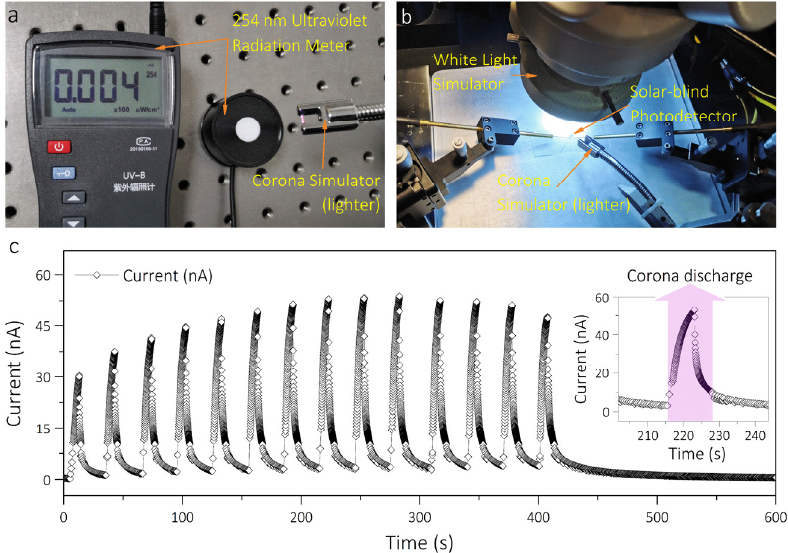
Figure 6. ( a ) Irradiation intensity test of corona simulator discharge; ( b ) a photograph of m-Ga 2 O 3 solar-blind PD performing a corona discharge simulation test on a probe station; ( c ) time-dependent corona discharge photoresponse of m-Ga 2 O 3 solar-blind PD, the inset shows the photoresponse of a single corona discharge, and the purple area is the corona discharge process.